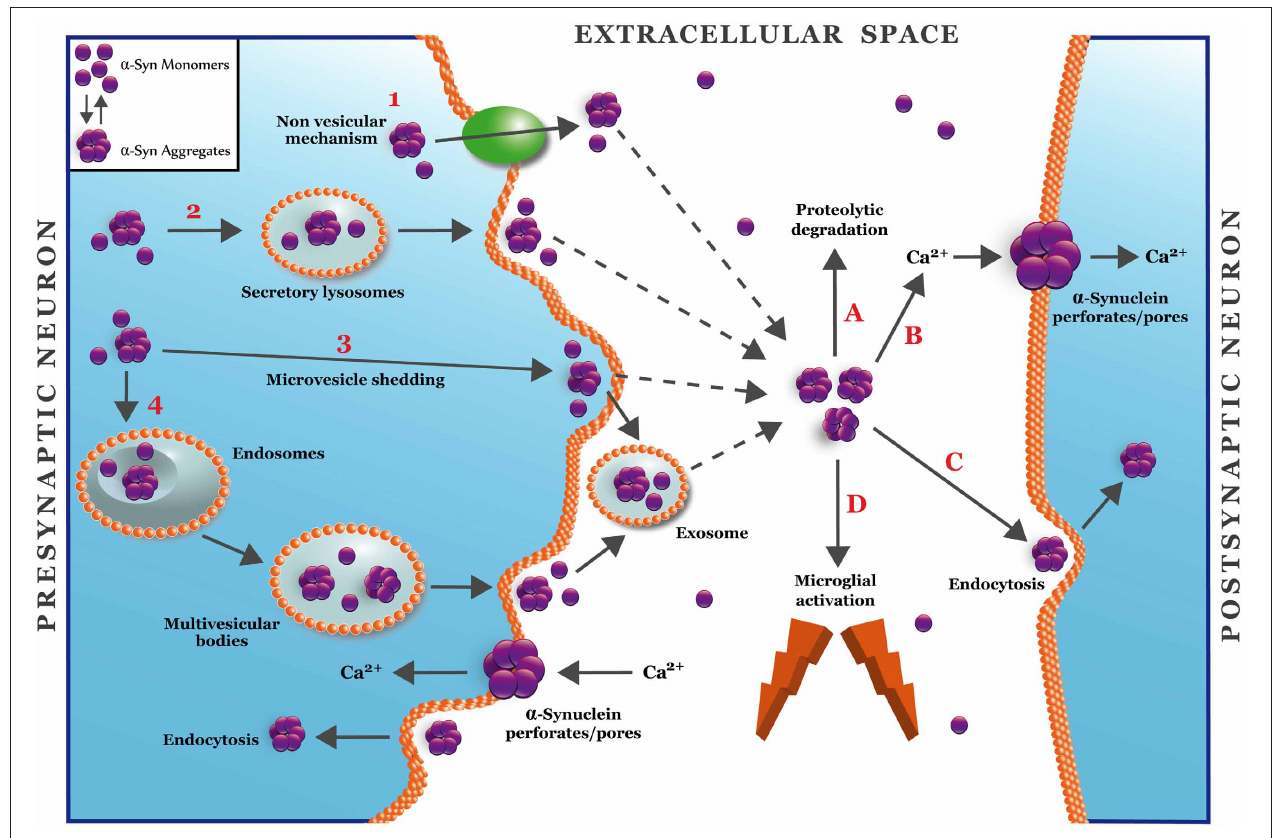
FIGURE 2 | A hypothetical model for secretion and synaptic targets of α -synuclein oligomers. The figure shows four different mechanisms for unconventionalsecretion of α -synuclein (Nickel and Rabouille, 2009). Mechanism 1 depicts a non-vesicular translocation of α -synuclein mediated by an unknown transmembrane protein located at the plasma membrane. Mechanisms 2–4 depict vesicular mechanisms for α -synuclein secretion that involve lysosomes (2), microvesicle shedding (3), or endosome/multivesicular